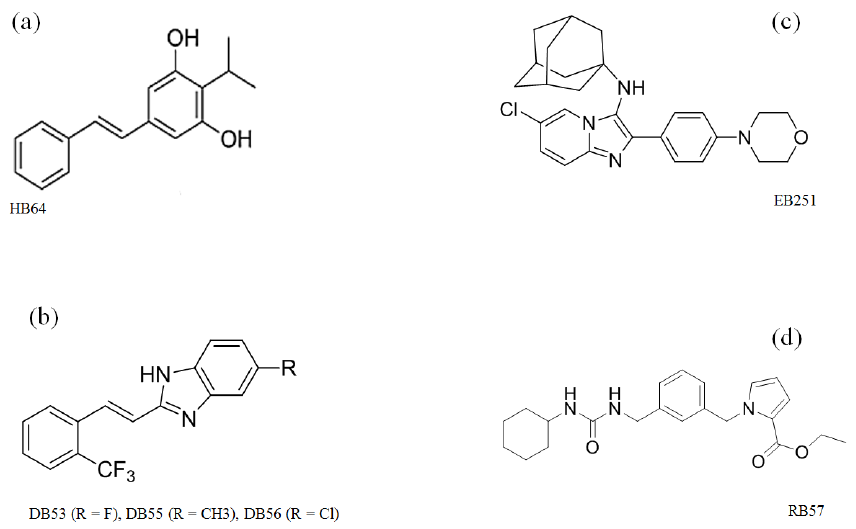
Figure 1: Natural stilbene and its synthetic derivatives evaluated in this study a) Natural stilbene, isopropylstilbene (HB64); b) (E)-styryl-1H-benzo[d]imidazoles with DB53 (R=F), DB55 (R=CH3), DB56